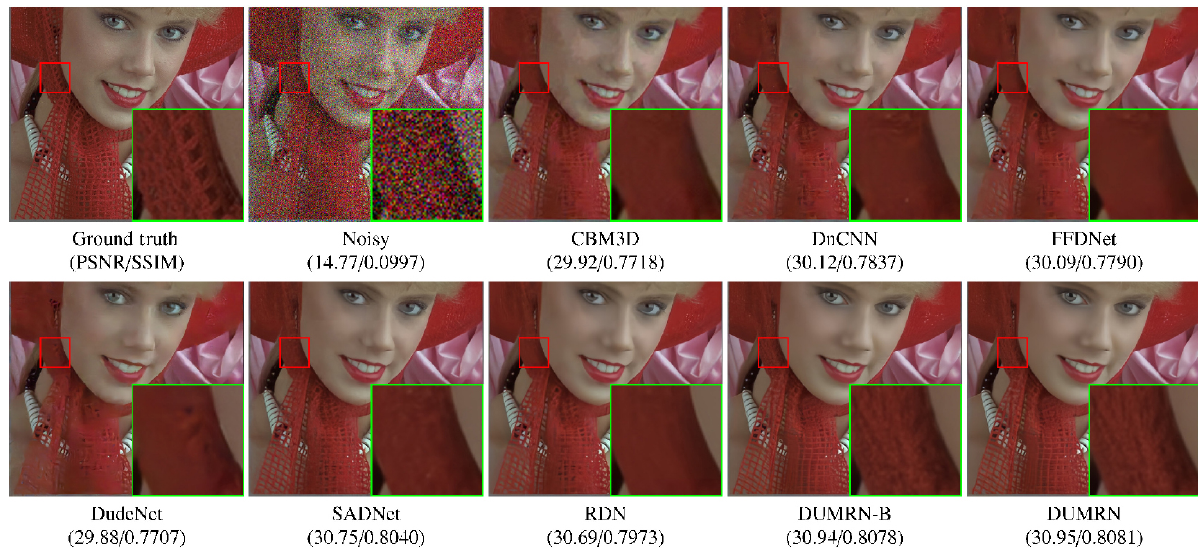
Fig. 4 Color image denoising results on image kodim04 from Kodak24 with noise level σ = 50.